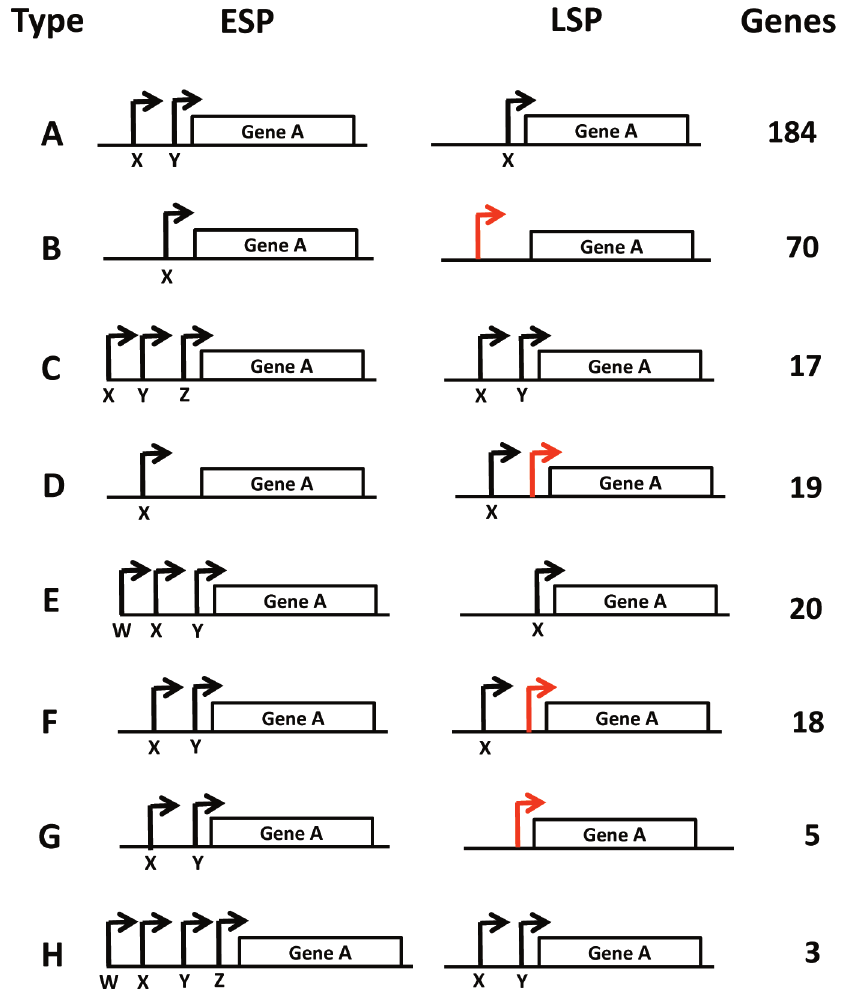
Figure 4. Use of alternate TSSs at LSP compared to ESP. Letters A to H annotate the different categories of arrangements of TSSs found at LSP compared to ESP that we were able to identify. Letters X, Y, Z and W represent TSS positions at ESP and LSP. The number of genes for which each type of rearrangement occurs is shown. For nucleotide positions of TSSs and genes to which the different types of rearrangements apply see Table S2. Red arrows indicate TSS positions that were identified at LSP but not ESP. Rearrangements which apply to one or two genes are shown in Fig.